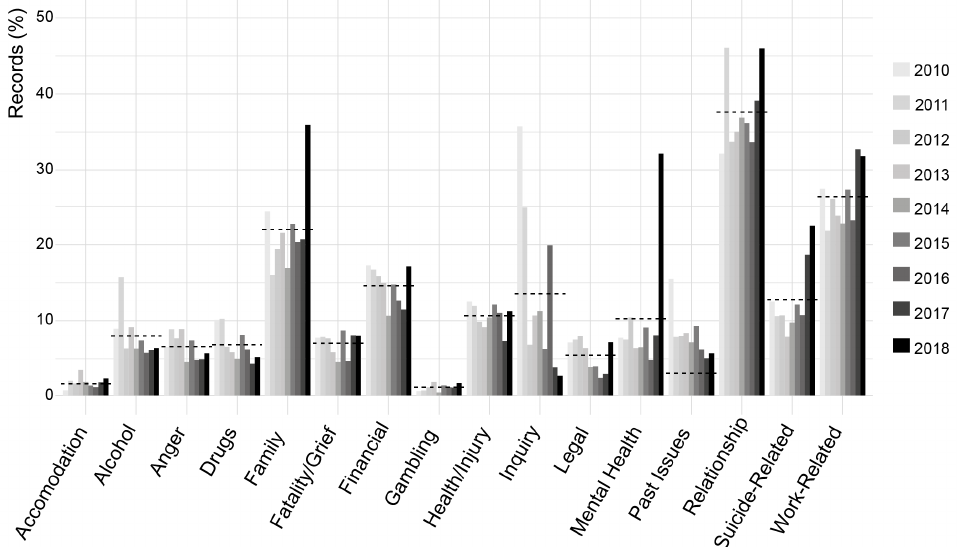
Figure 4. Distribution of presenting concerns over the years 2010 to 2018. Dashed lines indicate the mean percentage of records over the years 2010–2018 for each concern category.